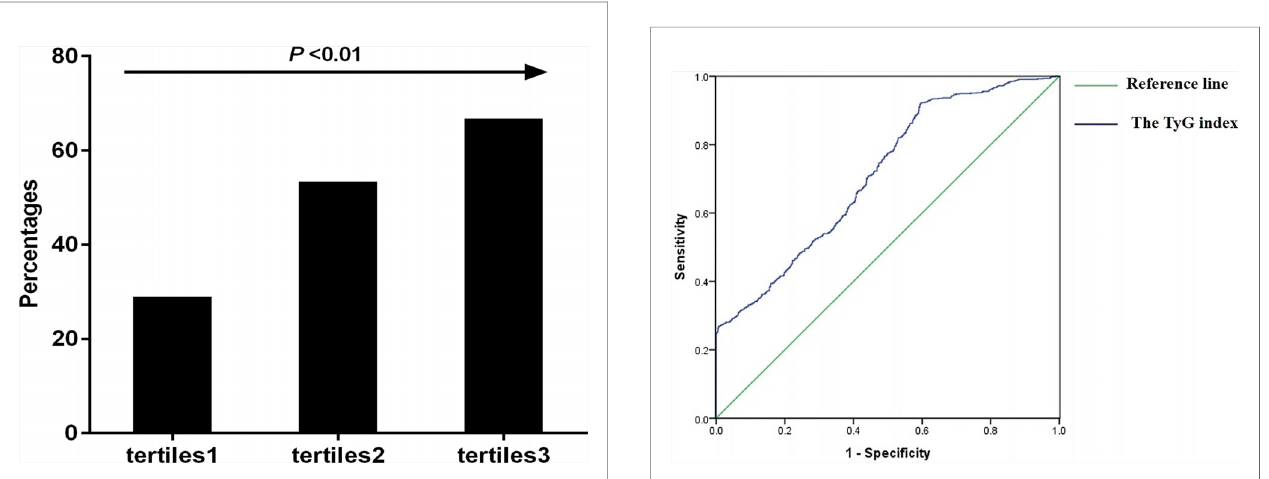
FIGURE 2 | Receiver operative characteristic (ROC) curves of the TyG index for predicting the incident of